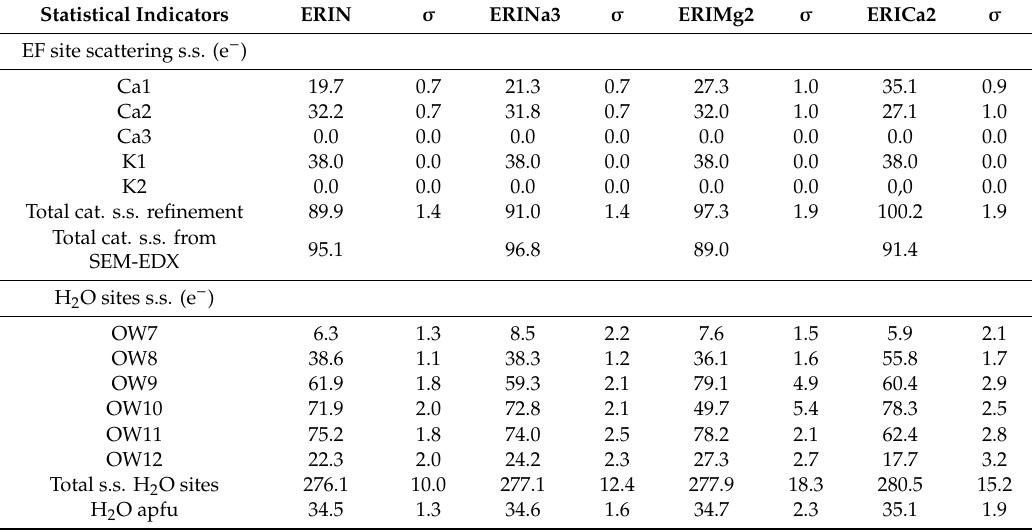
Table 4. z coordinates of Ca1 and Ca2 cation sites; individual and average T–O bond distances; Al population at T1 [Al(1)] and T2 [Al(2)] tetrahedral sites as calculated from the Jones’